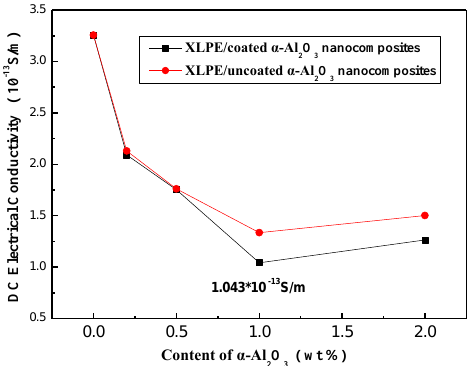
Figure 10. The relationship of the coated α-Al 2 O 3 content and DC electrical conductivity of XLPE/coated α-Al 2 O 3 nanocomposites and XLPE/uncoated α-Al 2 O 3 nanocomposites.